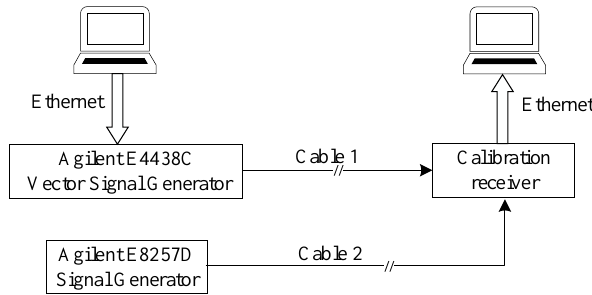
Figure 9. Hardware connection of the experimental